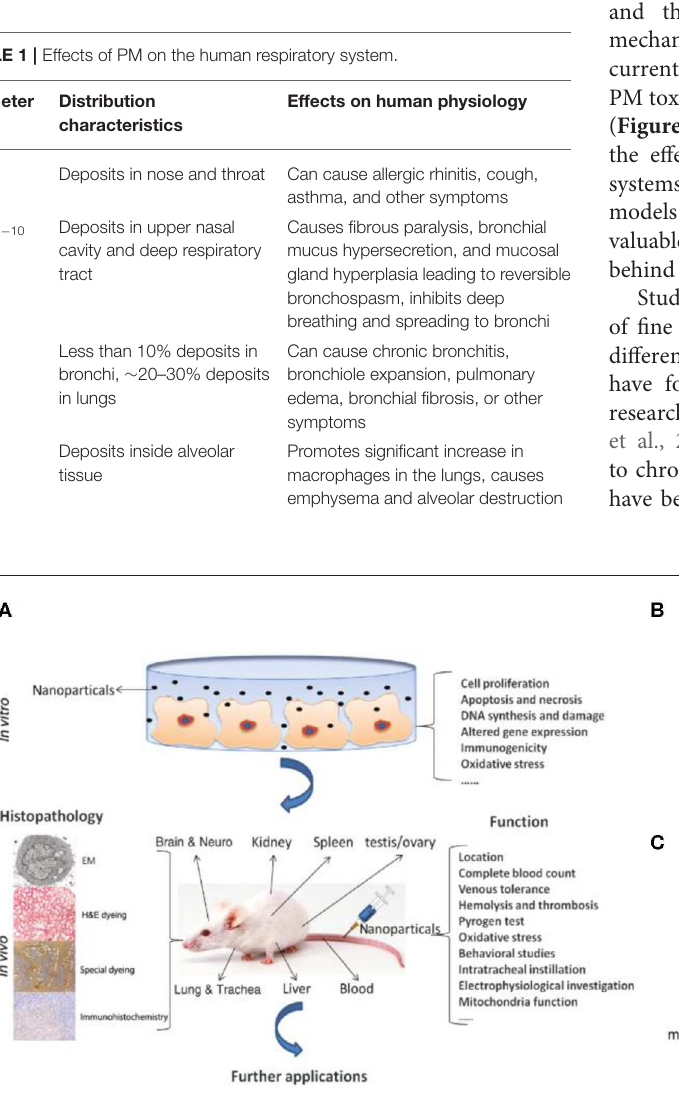
Frontiers in Bioengineering and Biotechnology |